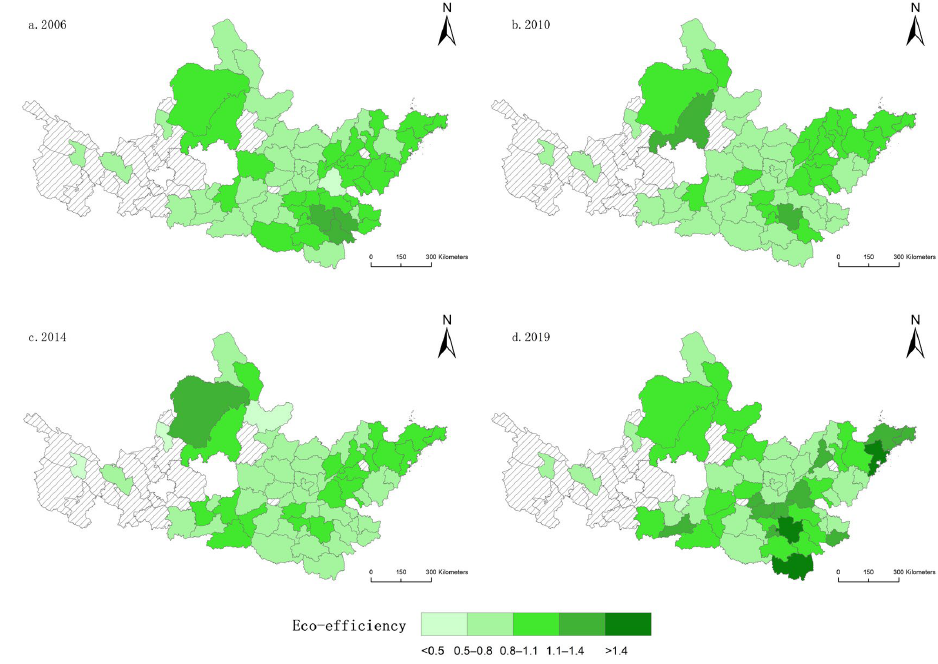
Figure 5. Spatial patterns of ecological efficiency in ( a ) 2006, ( b ) 2010, ( c ) 2014, and ( d ) 2019 in the Yellow River basin, China.